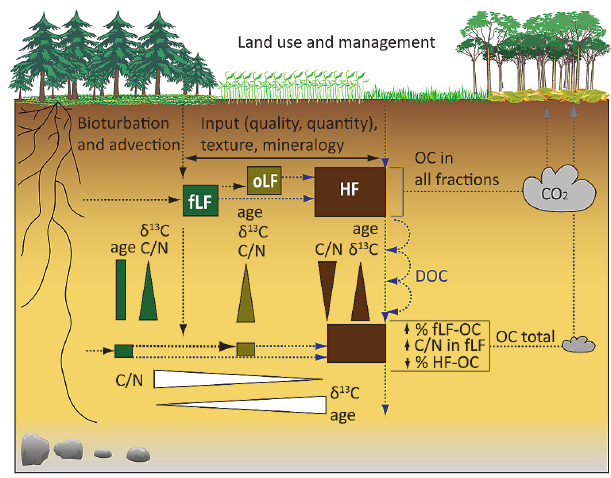
Fig. 13. Summary of characteristics of density fractions in topsoil and subsoil layers and their relation to soil respiration (fLF: free light fraction, oLF: occluded light fraction, HF: heavy fraction, OC: OC